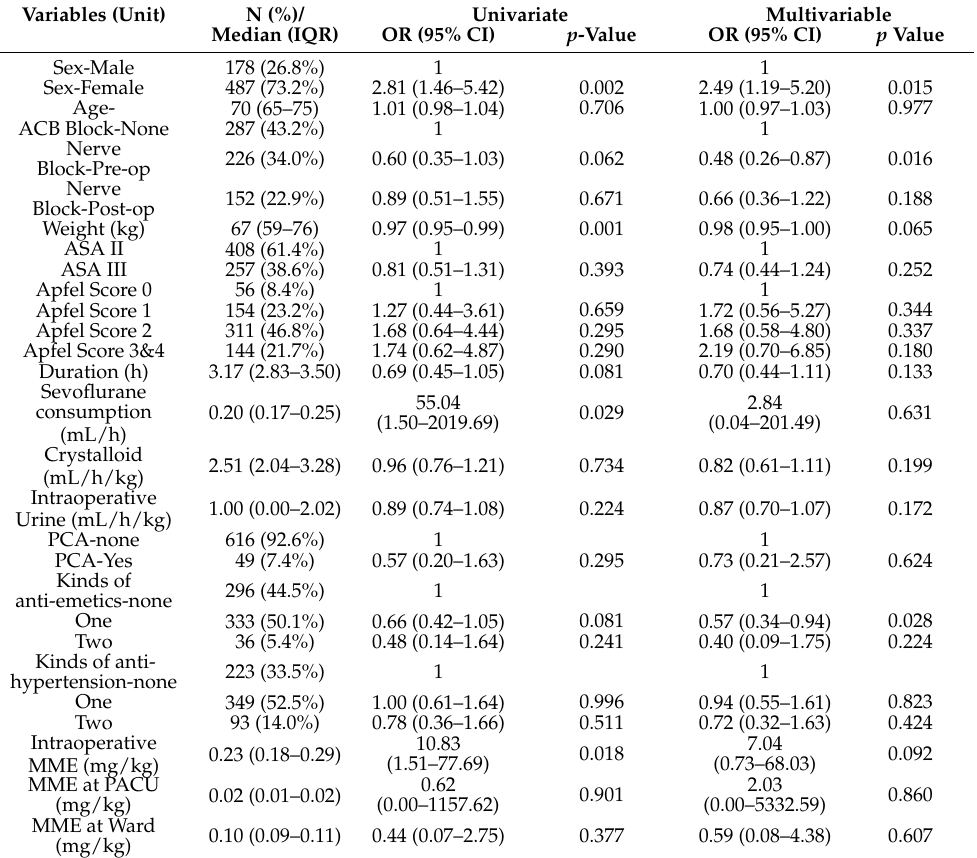
Table 2. Univariate and multivariate logistic regression of postoperative vomiting risk.